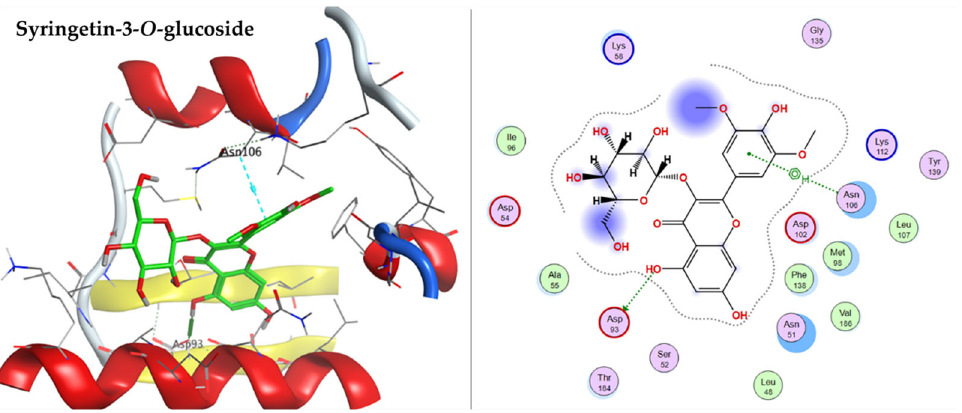
Docking studies reveal that 7 ‐ oxo ‐ dehydroabietic acid, caffeic acid, narcissoside (Iso ‐